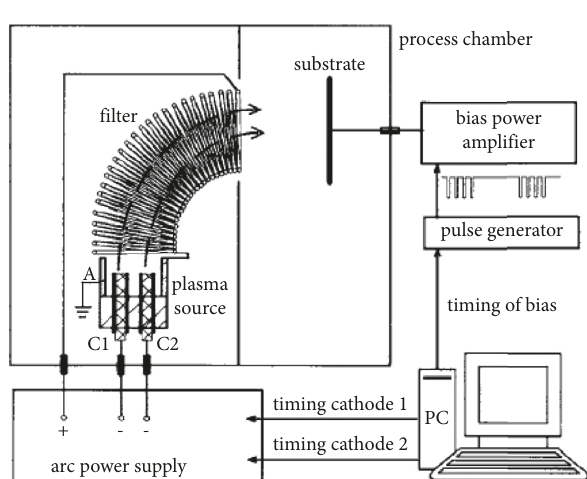
Figure 1: Schematic diagram of the system of filtered cathodic vacuum arc plasma system